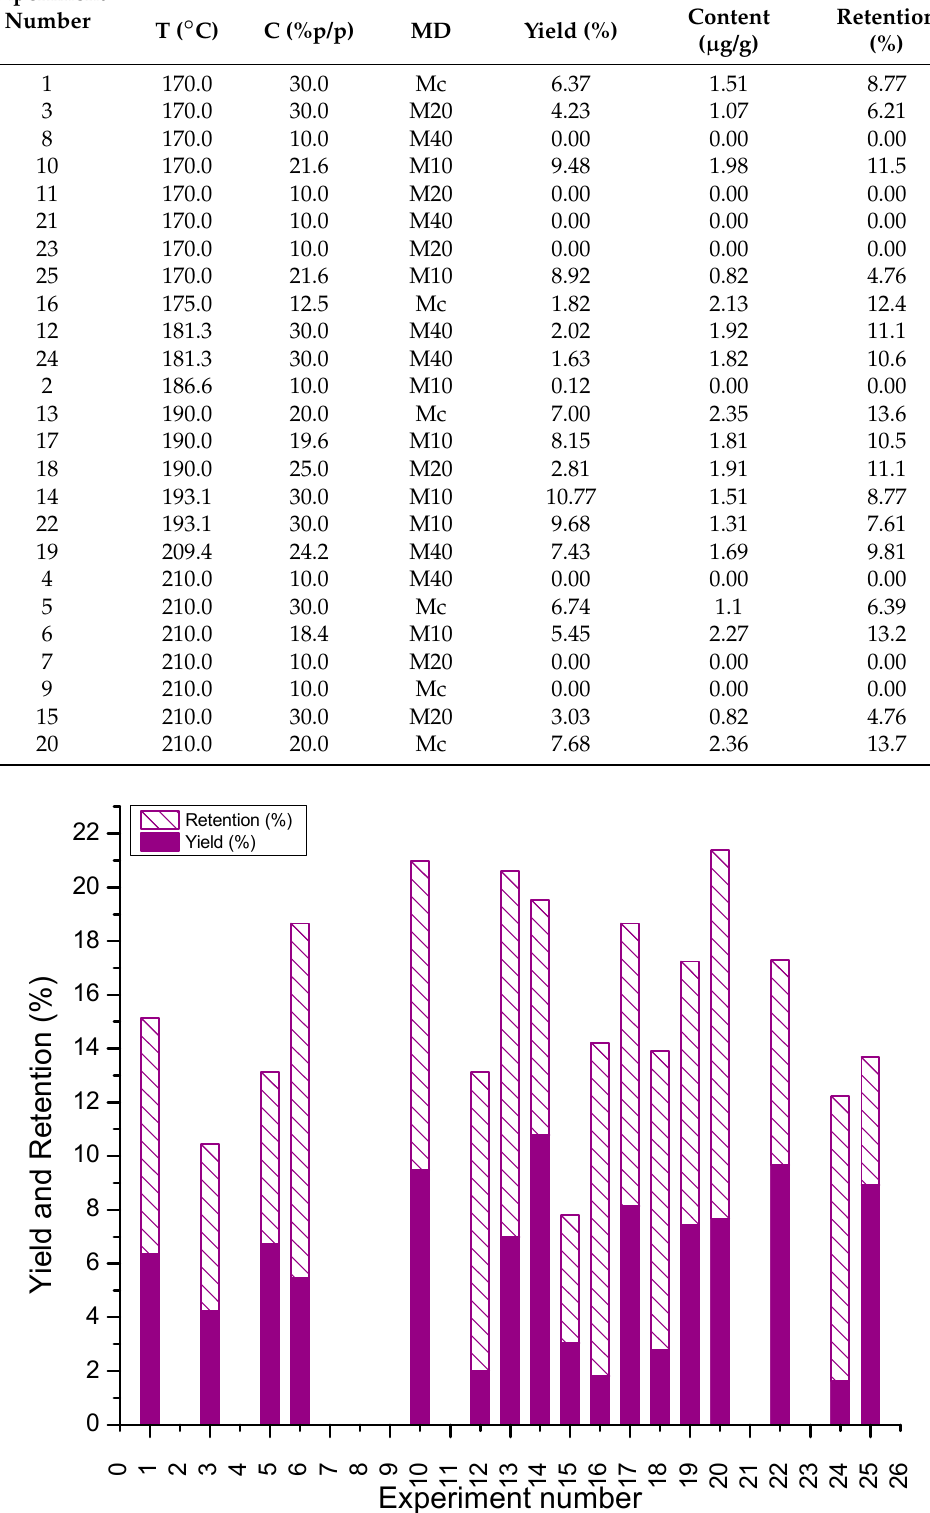
Table 1. Experimental results of dry powder yield, content and retention of quercetin 3- D -galactoside. Experiment